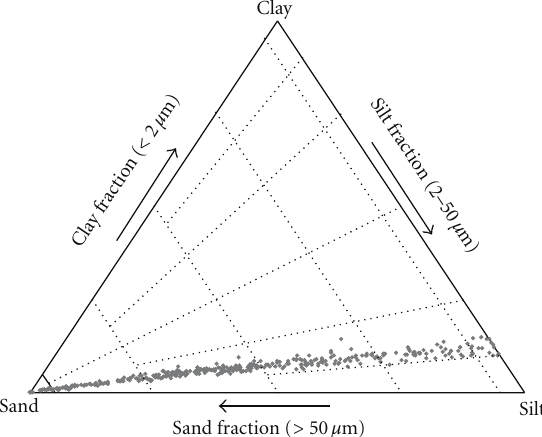
Figure 2: Triangular diagrams of Flemming textural classification.